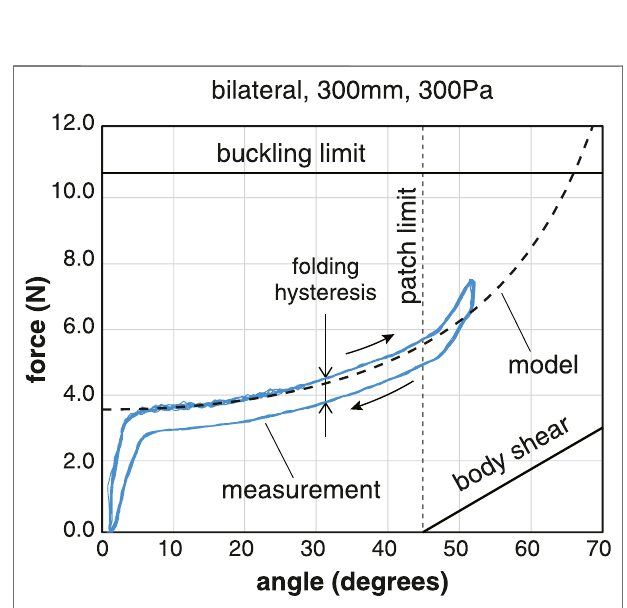
FIGURE 10 | Comparison of the theoretical pressure of model and measurementresults.Theconditionsareabilateraljointwithadiameterof300 mm andpressureof300Pa.Thepullingangleofthetendonis30 ° .Besidesthetorque due to internal pressure, hysteresis related to the folding of the fabric, the gravity, the shear deformation, and the buckling limit is also